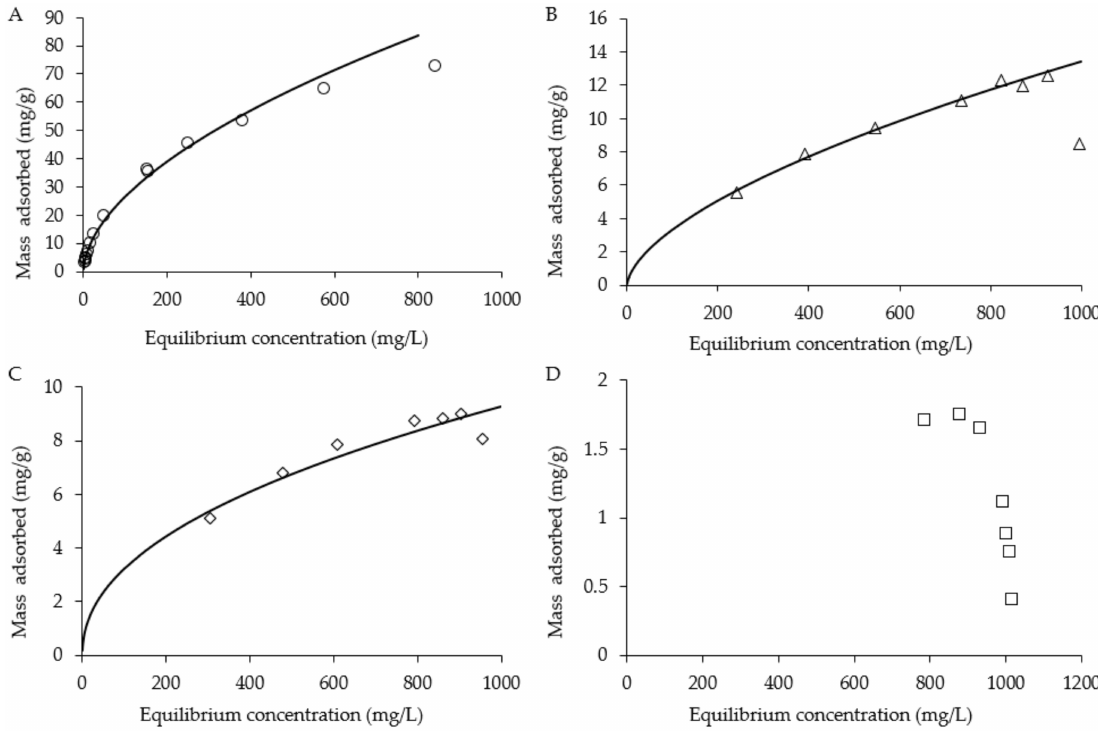
Figure 2. Adsorption isotherm of 1,4-dioxane on ( A ) GAC, ( B ) XAD4, ( C ) XAD16 and ( D )